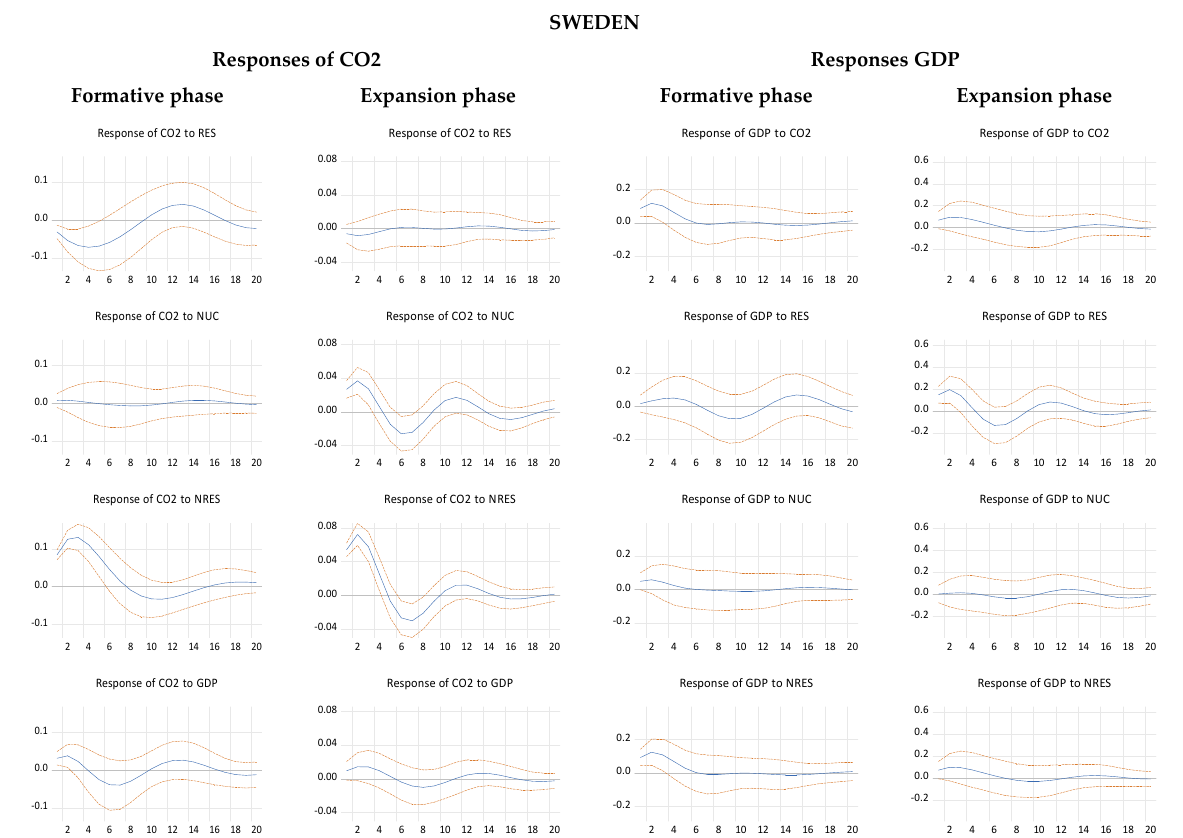
Figure 3. Responses of CO 2 emissions and GDP to shocks in another variables in formative and expansion phases in Spain.